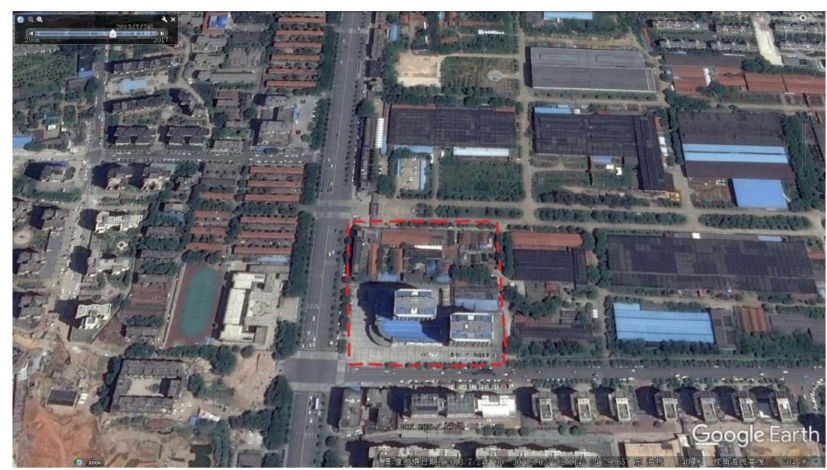
Figure 4. 2013 site morphology.